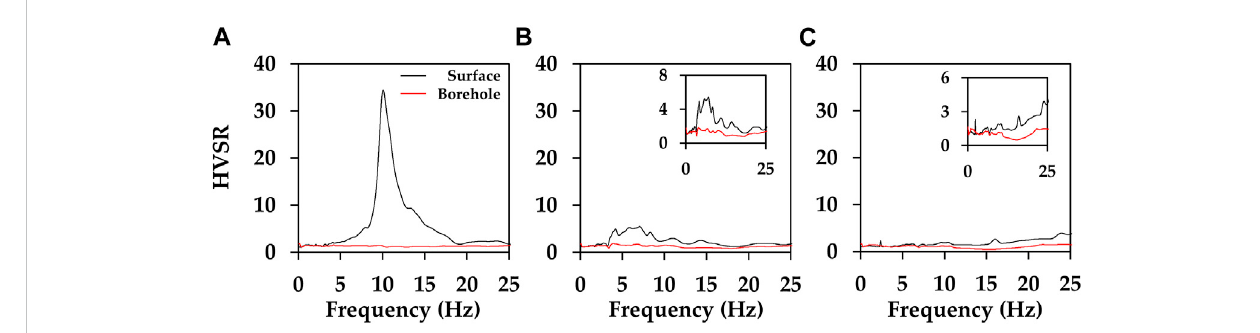
Comparison of HVSR for surface and within motions; black solid line is surface motion at the ground surface, and red solid line is motion within the rock layer: stations (A) HAMB, (B) IMWB, and (C)